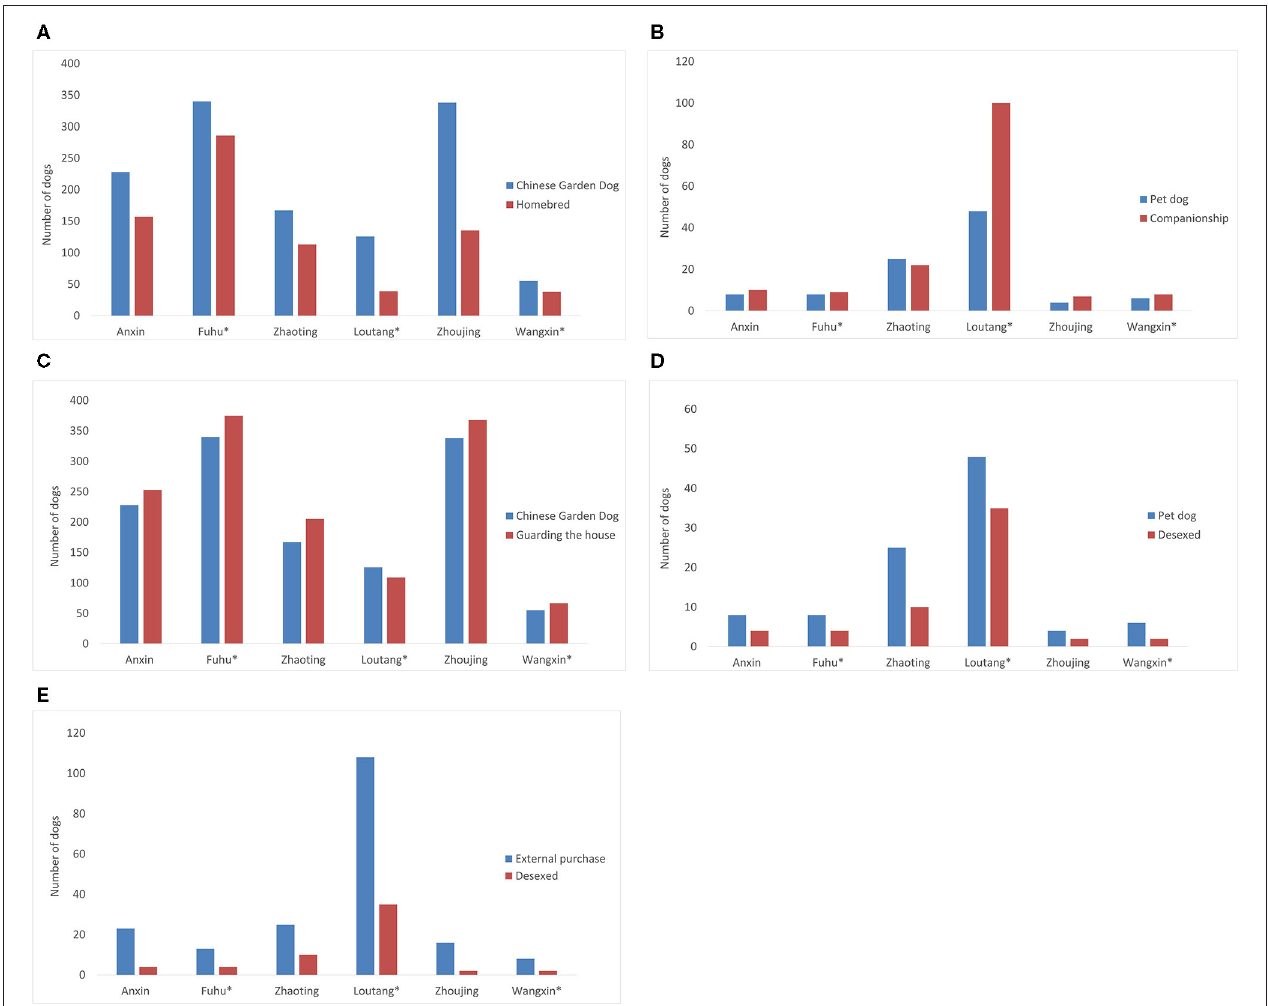
FIGURE 2 | Selected pairs of demographic parameters that exhibited strong correlation in dog questionnaire surveys conducted in 6 selected villages, Jiading district, Shanghai in 2020 (*non-model villages, without rabies control): (A) number of Chinese Garden Dog breed versus homebred status (Spearman rank correlation r SP 0.943, P = 0.005); (B) number of pet dog breeds and use for companionship purposes ( r SP 0.986, P < 0.005); (C) number of Chinese Garden Dog breed and use for guarding purposes (